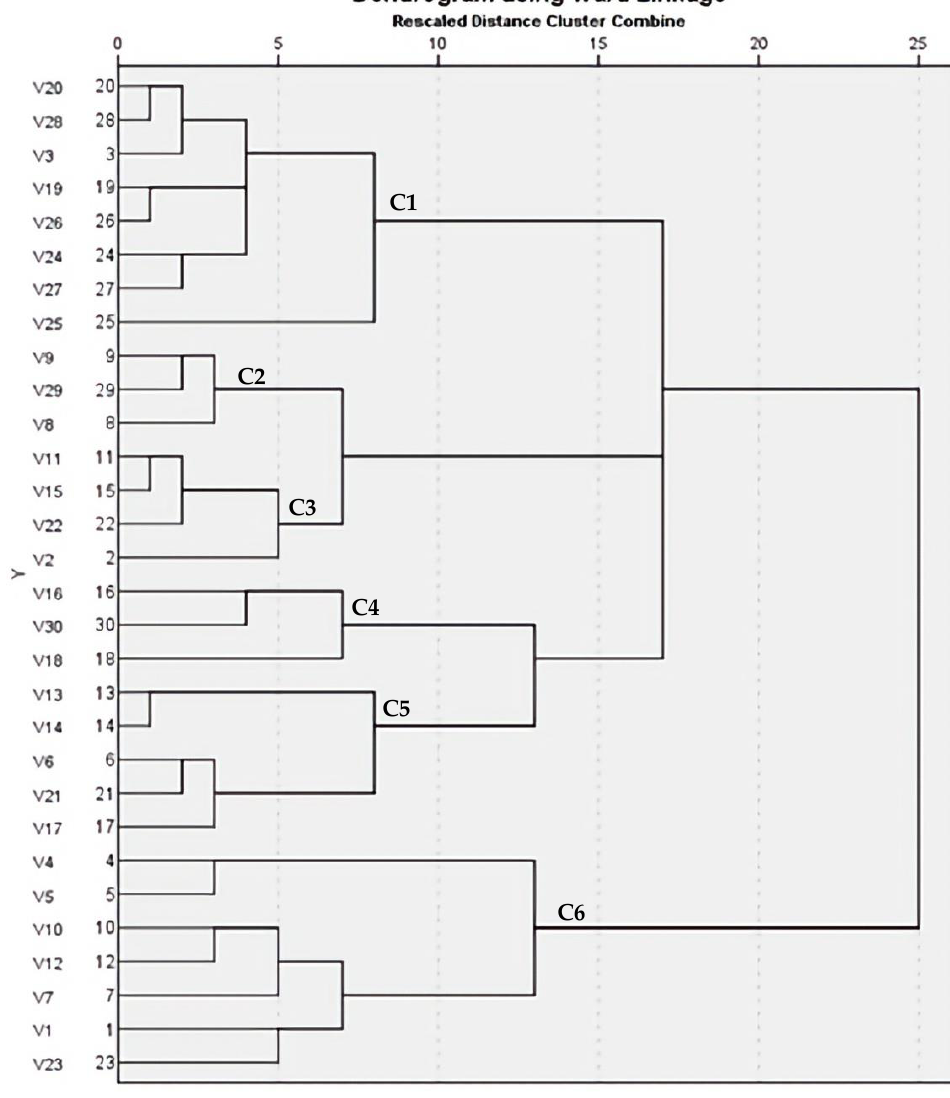
Figure 8. Dendrogram of 30 MRSA isolates showing genetic heterogeneities.